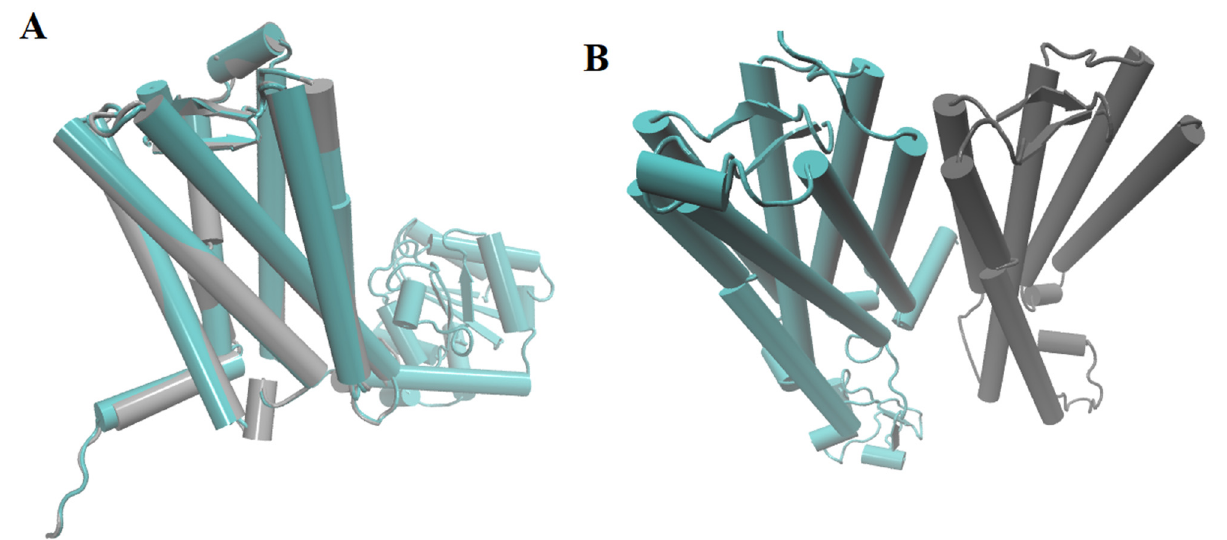
Figure 3. The 3-D models of human (cyan) or rat (gray) of MT1 ( A ) and MT2 ( B ) melatonin receptors. High similarity in the general disposition, conformations, and binding sites of the four receptors is noteworthy.